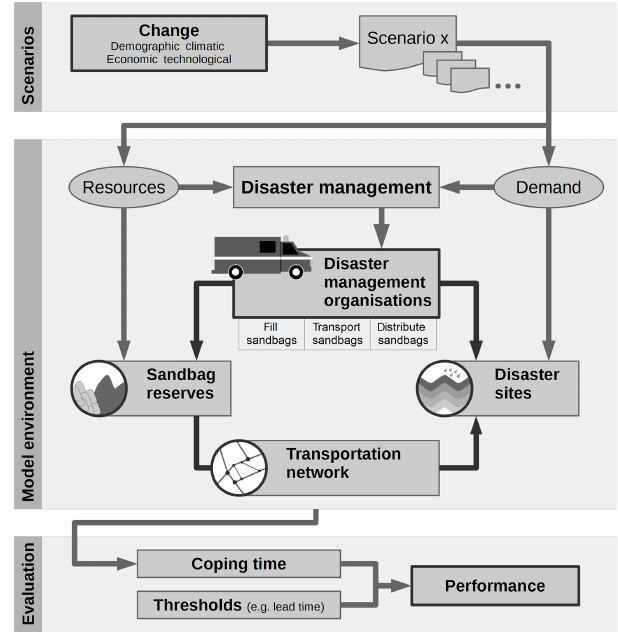
Figure 1. Conceptual diagram of the model. The model environ- ment shows the entities and their relationships that are simulated in the model. The influence of change is incorporated via scenarios that allow us to change resources (e.g., available DMO units), de- mand (e.g., required amount of protection) and other boundary con- ditions. The performance of disaster management for each scenario is subsequently evaluated with respect to critical time thresholds (e.g., lead